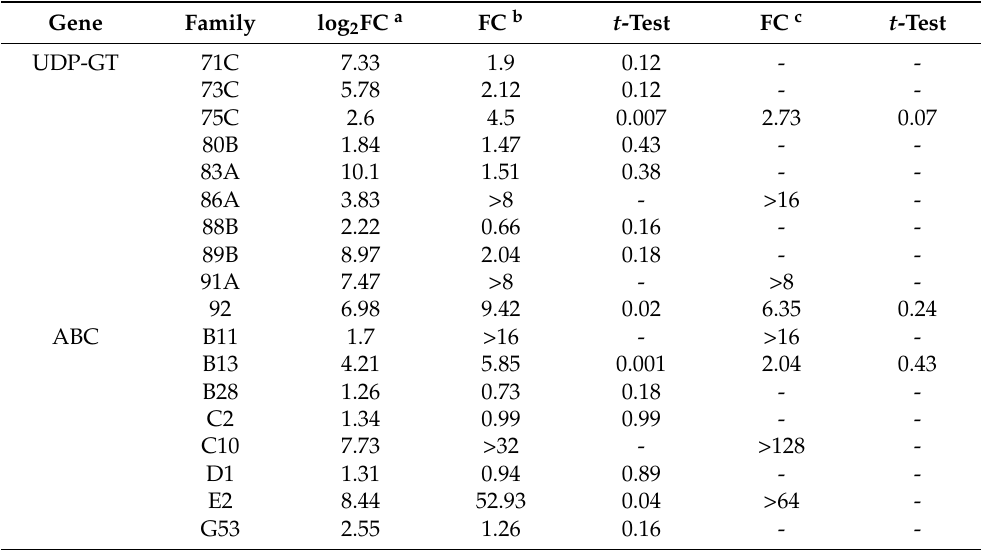
Table 2. Results of RNA-seq and relative transcript levels of glycosyl transferases and ABC transporters. Gene